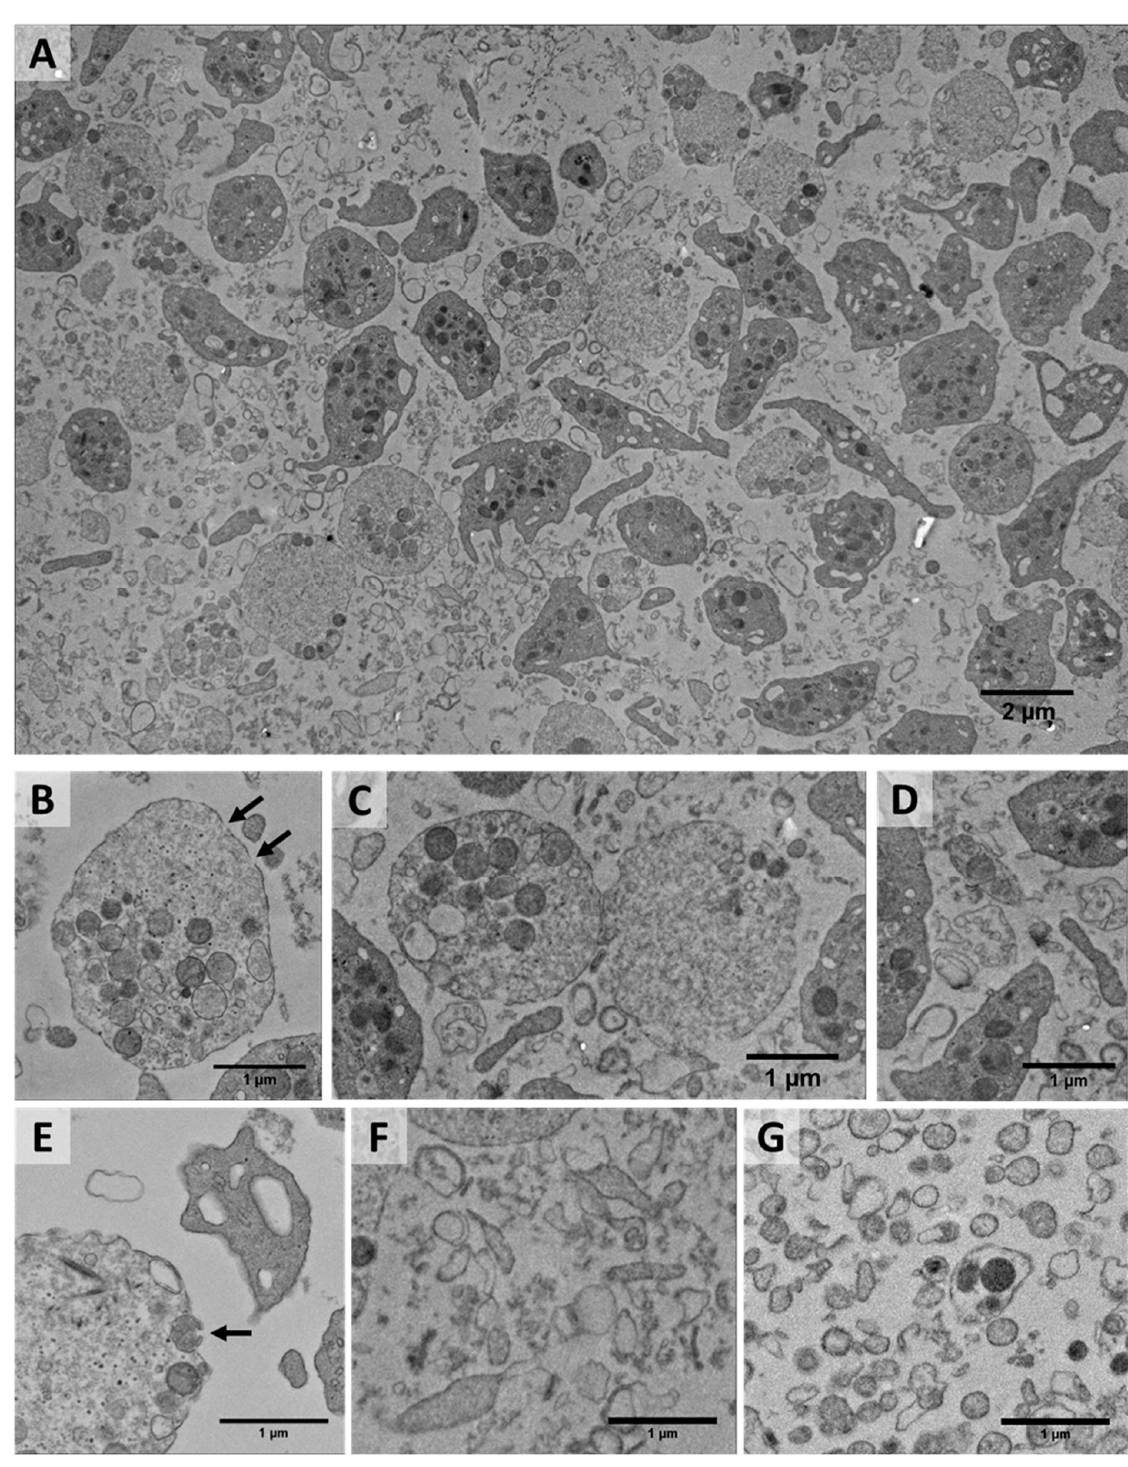
Figure 2. Illustrative thin-section electron microscopy images of platelets and platelet-derived microparticles (PDMPs) following exposure to 70 dyne/cm 2 shear stress. ( A )—morphological hetero- geneity of platelets and PDMPs, ( B , C )—platelet membrane thinning. ( D )—large irregular particles, likely fragments of platelets or platelet structures, ( E )—budding of platelet granules, ( F , G )—small “granule-like” circular or ellipsoidal particles with evident contrast density or devoid of contents. Microparticles were pelleted by high-speed centrifugation (20,000× g , 30 min). The arrows indicate membrane thinning areas. The scale bar represents 2 µm ( A ) or 1 µm ( B – G ). Direct magni fi cation: 3000× ( A – G ).